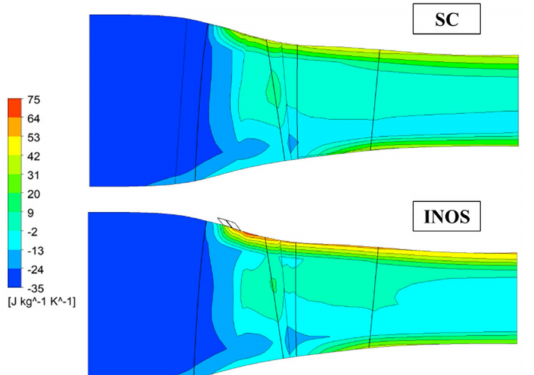
Figure 9. Circumferentially-Averaged static entropy distribution at peak adiabatic efficiency condition.